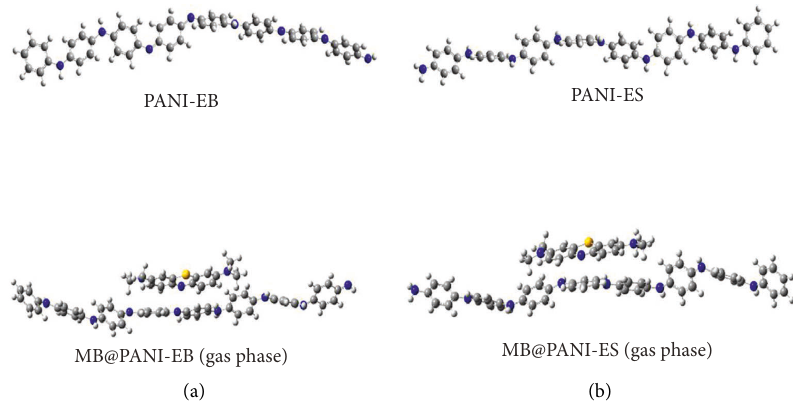
Figure 6: Structures of the (a) PANI-EB and (b) PANI-ES before and after the adsorption of MB from ab initio